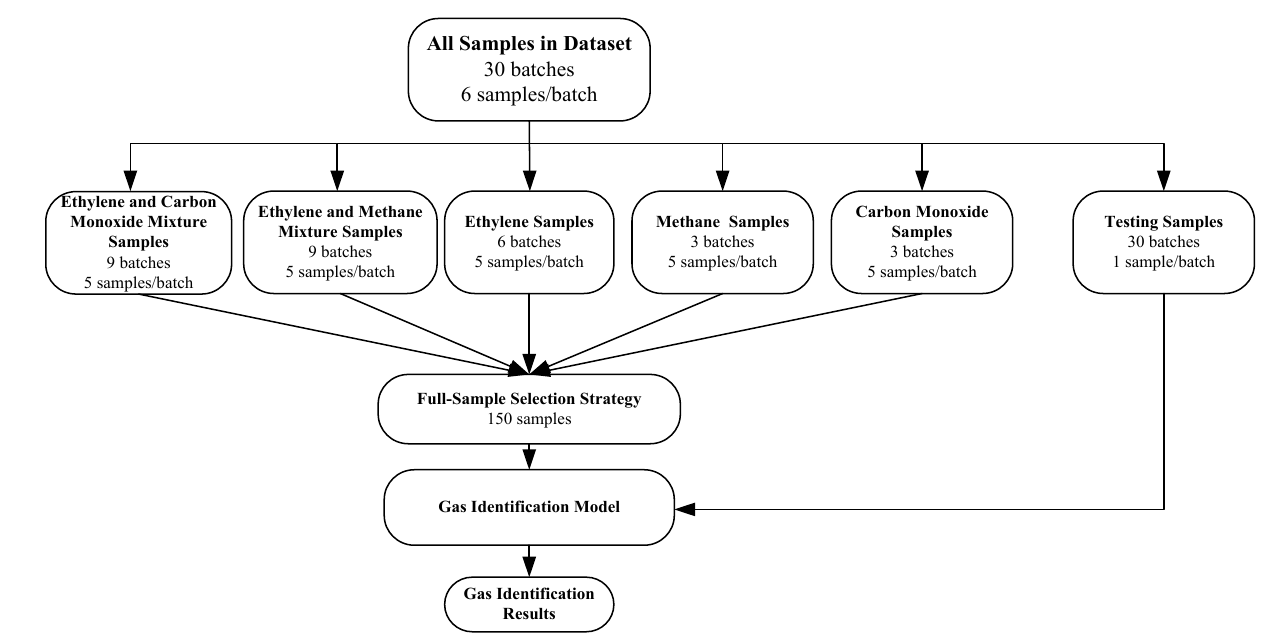
Figure 8. Full-sample selection strategy for gas mixture identification.